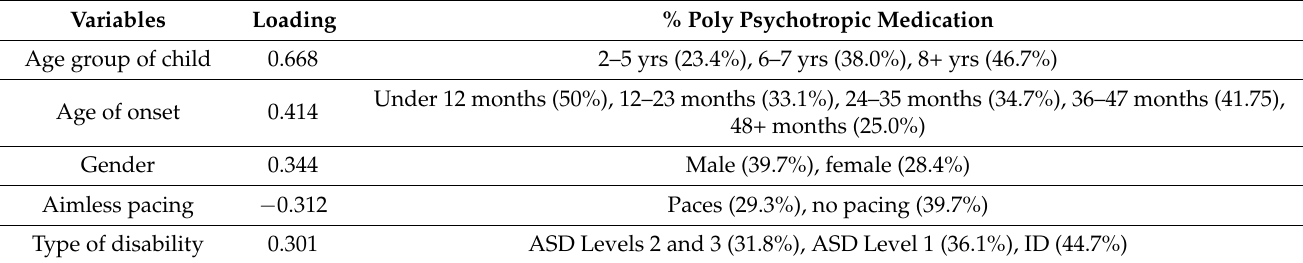
Table 4. The structure matrix of variables that best discriminated between children receiving poly psychotropic medication and the percentages within the subgroupings of the predictor